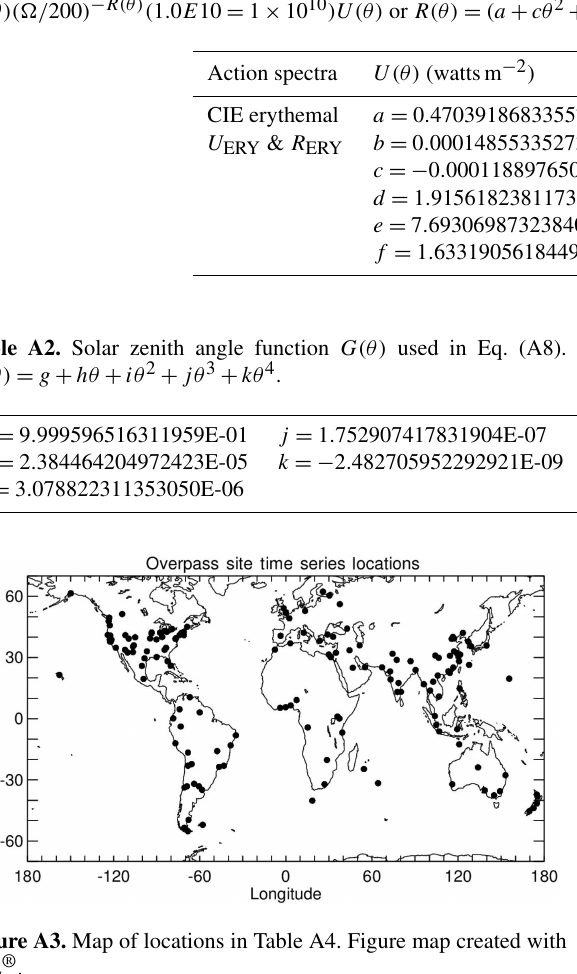
Table A1. Coefficients R(θ) and coefficient U(θ) for 0 < θ < 80 ◦ , Eq. (A4), and 100 < (cid:127) < 600DU for E((cid:127),θ) = U(θ)((cid:127)/ 200 ) − R(θ) ( 1 . 0 E 10 = 1 × 10 10 )U(θ) or R(θ) = (a + cθ 2 + eθ 4 )/( 1 + bθ 2 + dθ 4 + f θ 6 )r 2 > 0 . 9999 (see Fig. A1).